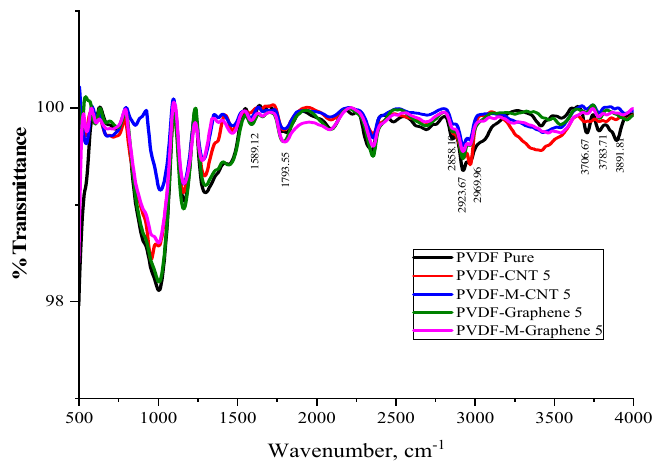
Figure 5. Overlay FTIR spectra of the acid-treated MWCNT/GNF-PVDF nanocomposites.